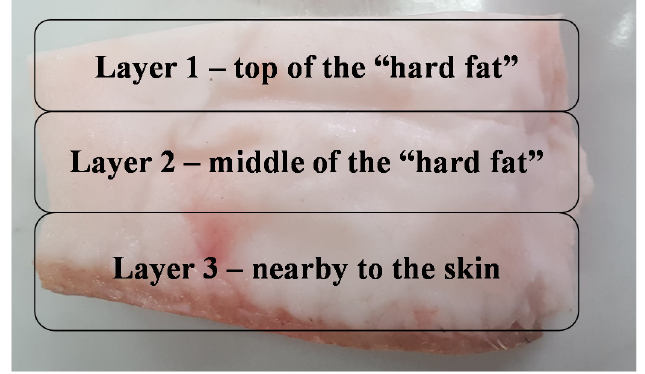
Figure 1. Sampling of the lipid fractions of Mangalitza hard fat.